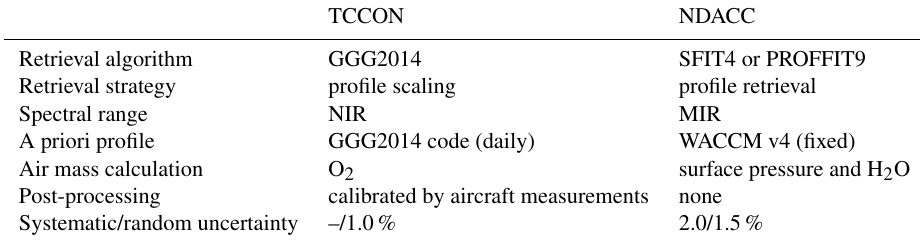
Table 2. The main differences between the TCCON and NDACC X N